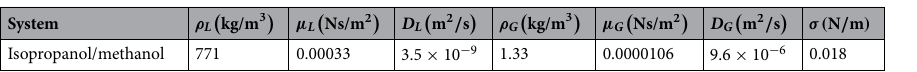
Table 3. The properties of the material (liquid density, liquid viscosity, liquid diffusion coefficient, gas density, gas viscosity, gas diffusion coefficient and surface tension) used for calculating the HETP in the binary